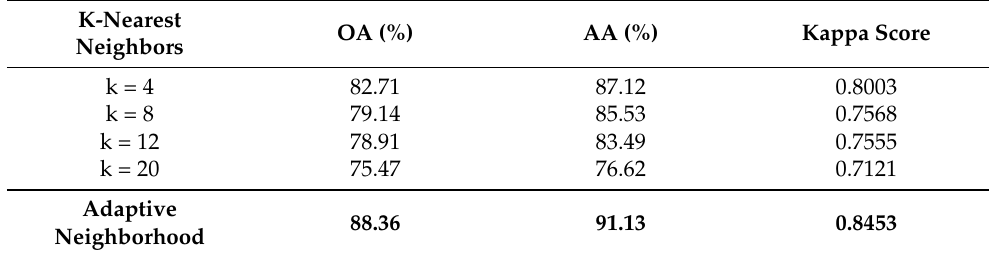
Table 6. Comparison of classification using different K-nearest neighbors in Indian Pines dataset. K-Nearest